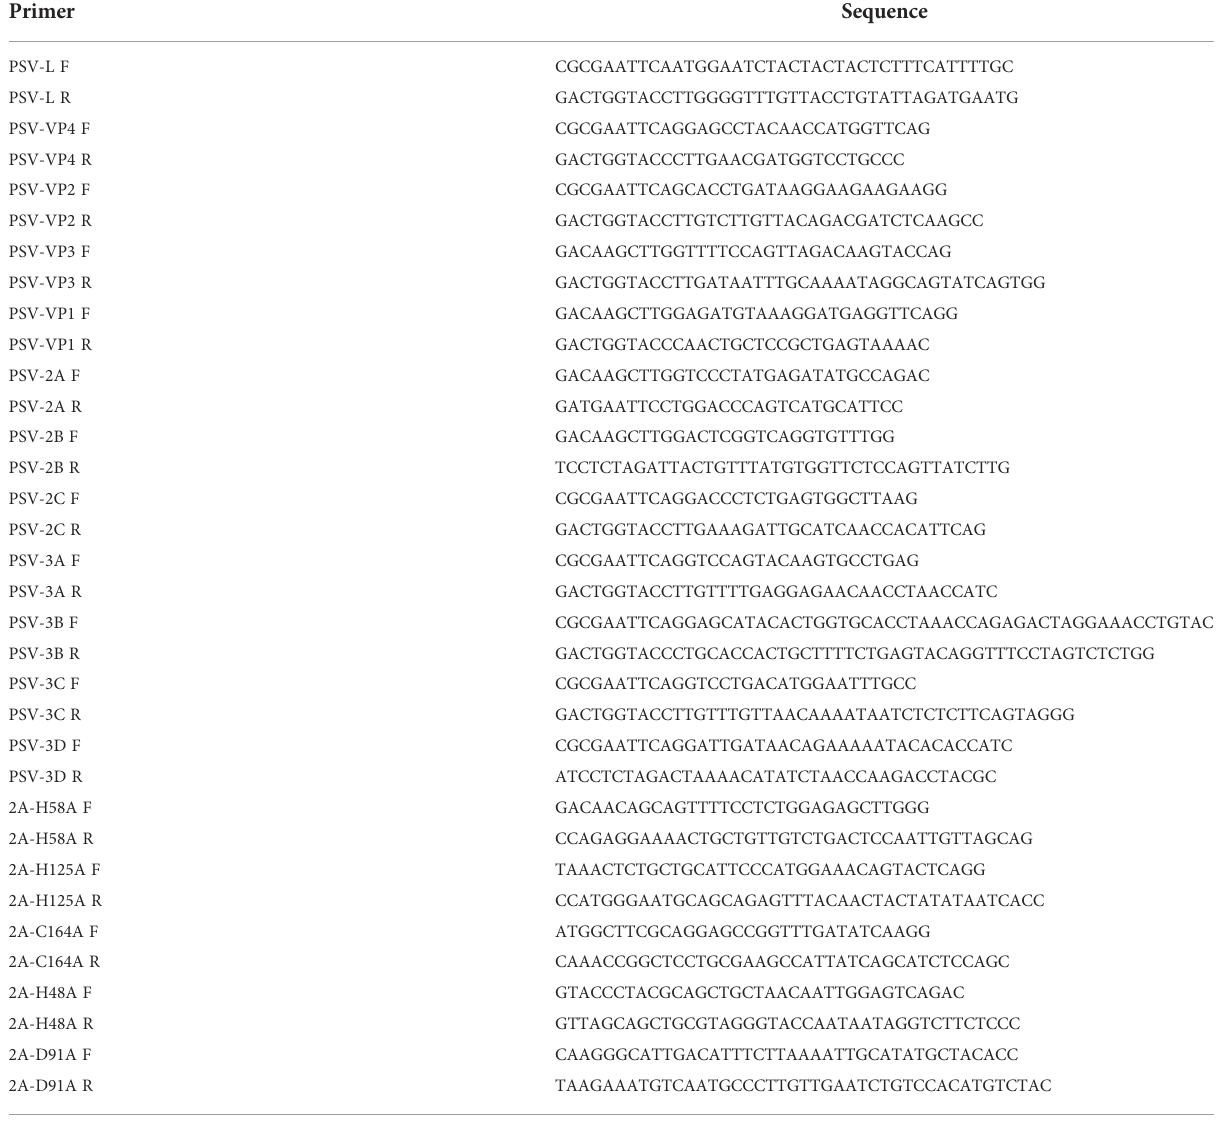
TABLE 1 The primers used for construction of plasmids expressing the PSV-encoded proteins and 2A mutants.